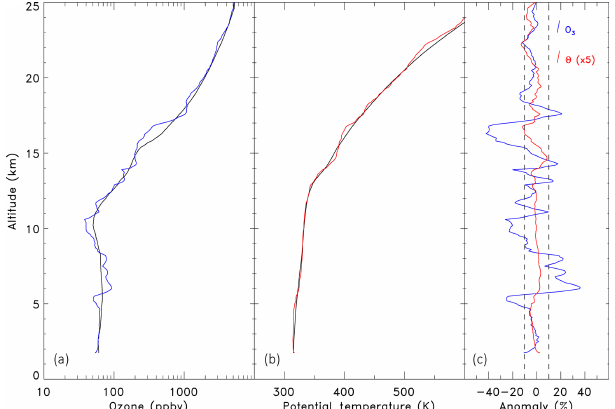
Figure 1. Vertical profiles of ozone ( a , solid blue) and potential temperature ( b , solid red) measured from Boulder, CO on 10 June 2008. The respective basic states are indicated by solid black curves in both panels. Panel (c) shows relative anomalies based on differ- ences between the measured and basic state profiles for ozone (solid blue) and potential temperature (solid red, scaled by a factor of 5). Dashed vertical lines denote the ± 10% threshold in ozone anomaly that is used to identify